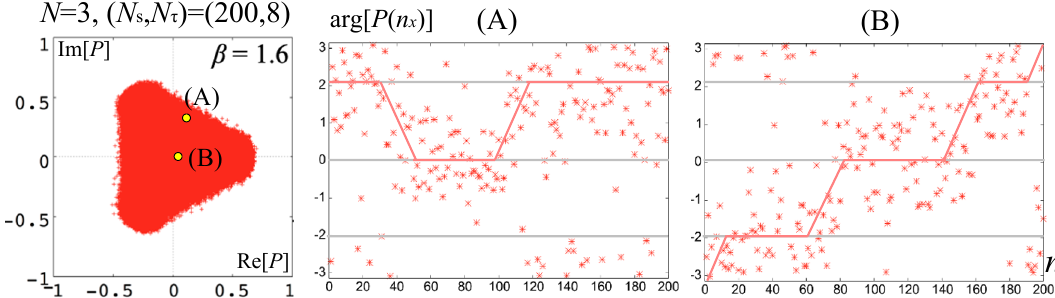
Figure 4 . (Left): distribution plot of the Polyakov loop for N = 3, (cid:12) = 1 : 6 with ( N s ; N (cid:28) ) = (200 ; 8) for the Z 3 -TBC with the two con(cid:12)gurations (A) and (B) pointed. (Center)(Right): the position dependences of arg[ P ( n x )] on 1 (cid:20) n x (cid:20) N s for the two selected con(cid:12)gurations (A) and (B) in the distribution plot. We show the three vacua by gray lines and the estimated vacuum transitions by red lines. (A) corresponds to a bion while (B) to three fractional instantons.